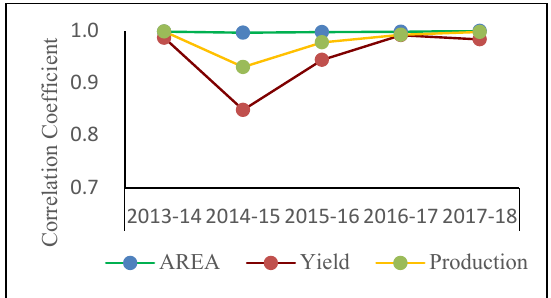
Figure 9. State-wise Correlation Coefficient between DES & FASAL Estimates (2013-2017)